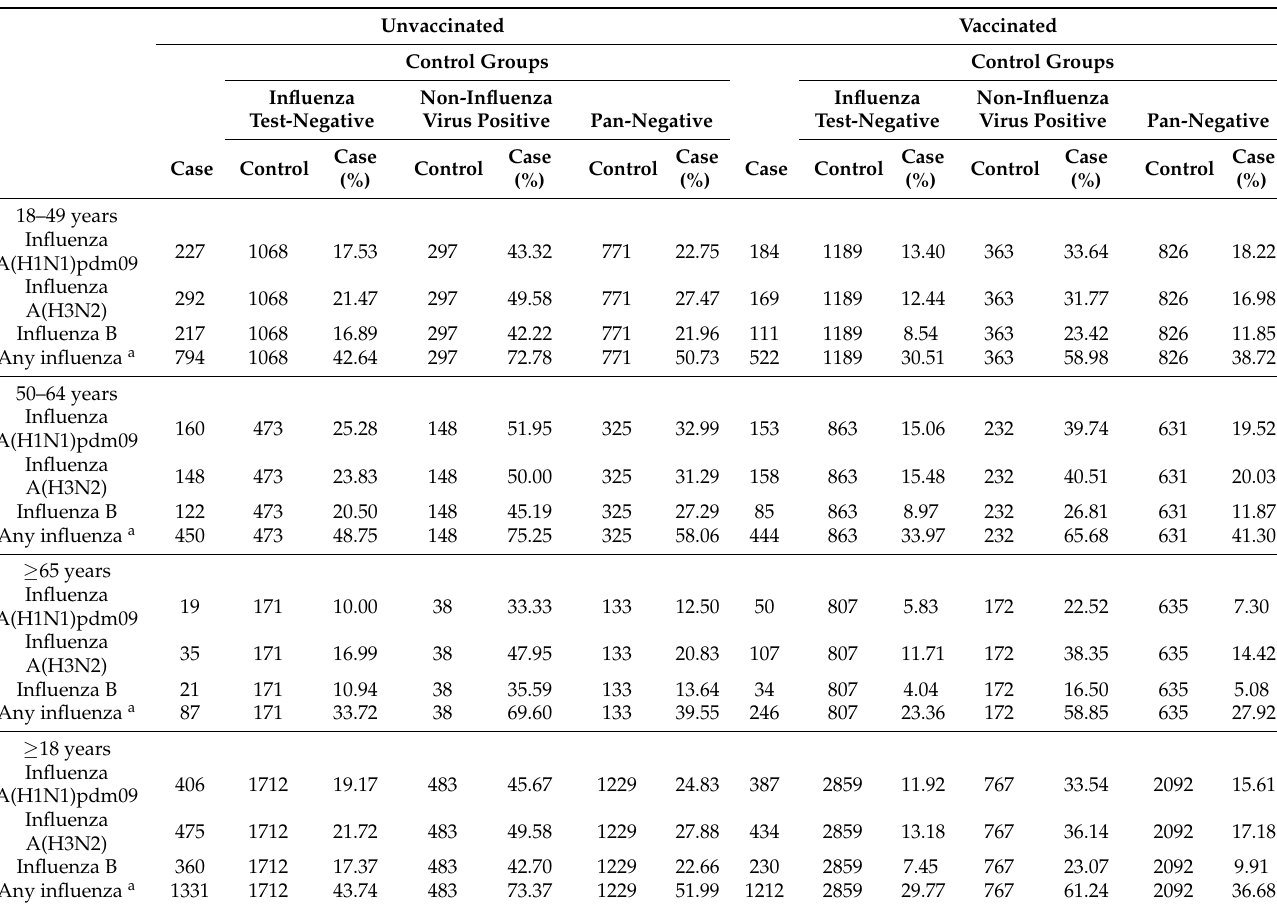
Table 2. Characteristics of patients by vaccination status in the test-negative design study with different control